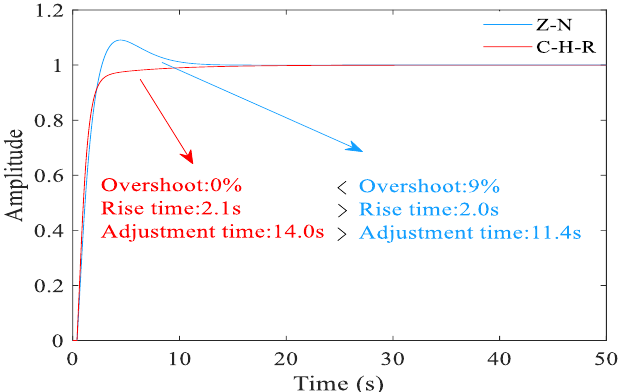
Figure 4. Comparison of unit closed-loop step response .